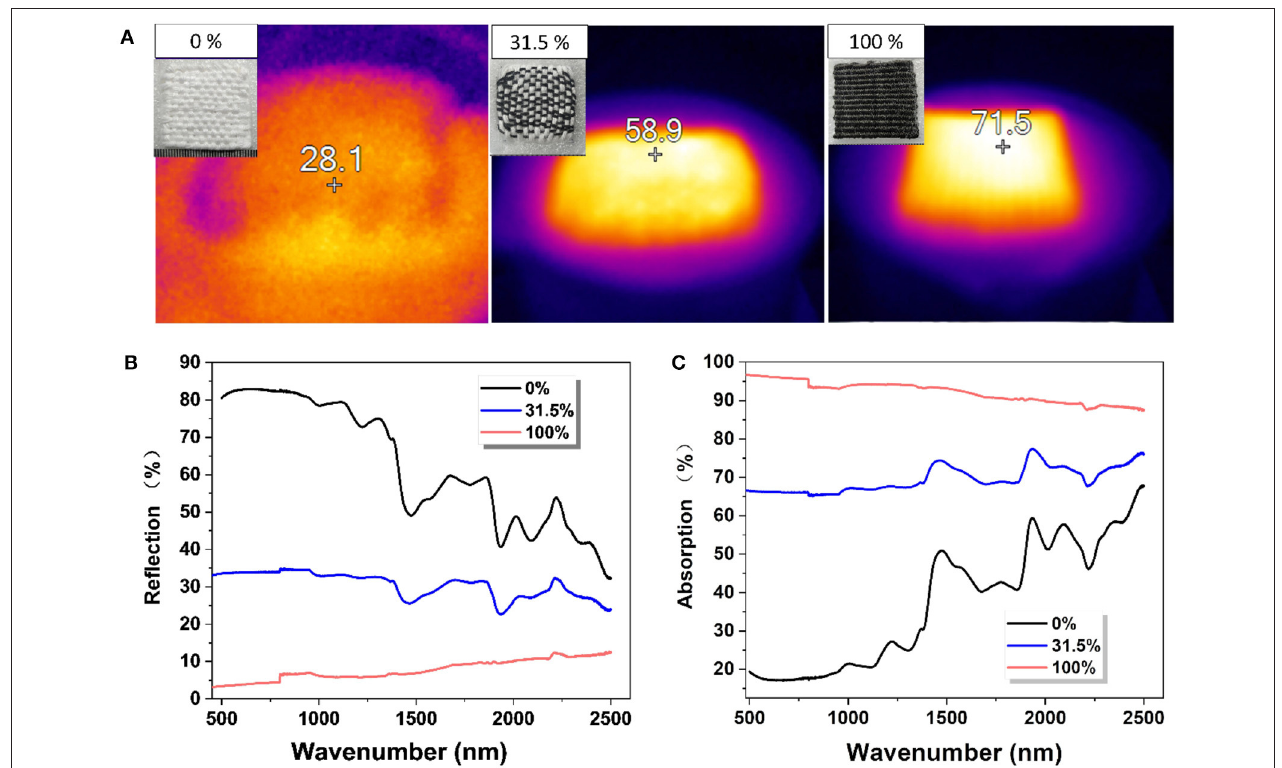
FIGURE 4 | (A) The steady surface temperature of fabric generators (4 × 4cm) with different values of CBS coverage under one sun illumination; (B) The reflection under increased wavenumbers for fabric generators with different values of CBS coverage; and (C) The absorption under increased wavenumbers for fabric generators with different values of CBS